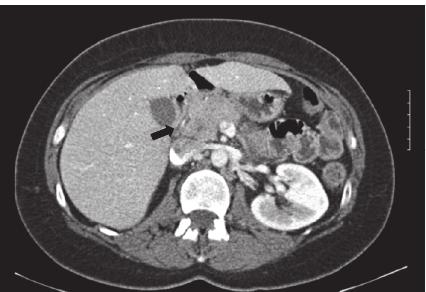
Figure 1: Computed tomogram of the abdomen and pelvis with contrast show abnormal fullness in the region of the pancreatic head measuring 4 × 1.5 cm (black arrow) with a dilated pancreatic duct measuring 5 mm.